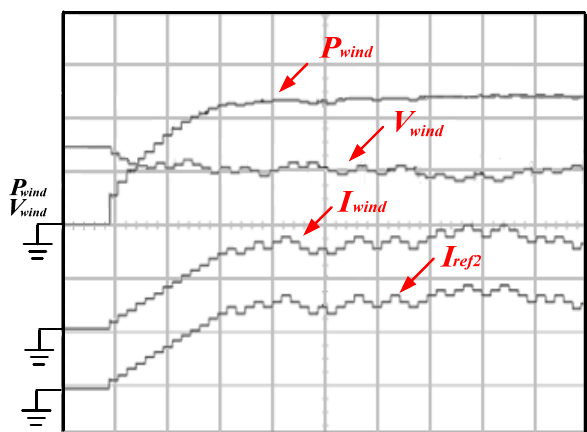
Figure 21. Measured output voltage, current and power waveforms of wind turbine at steady-state MPPT. ( P time : 5 s/div).